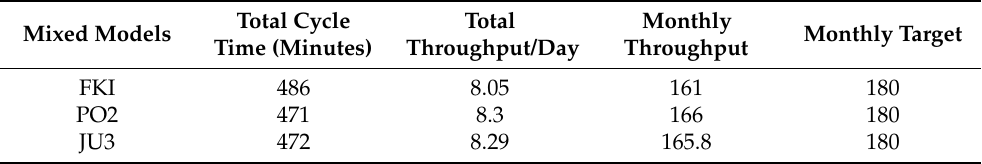
Table 3. Initial productivity model input using